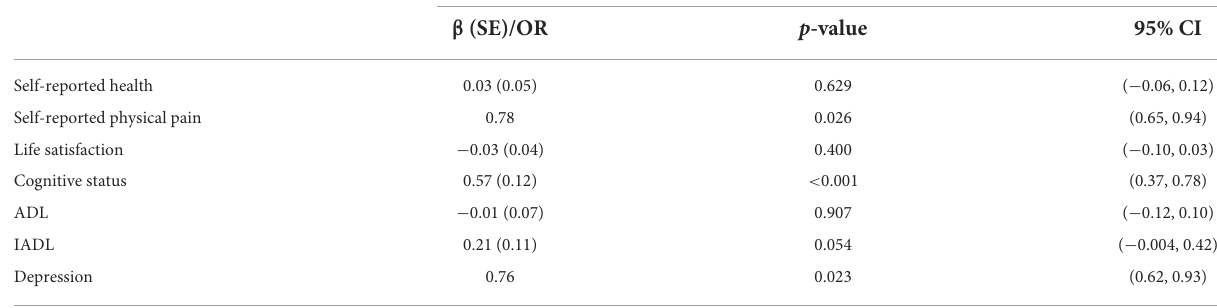
TABLE 3 Estimation of the intervention effect of retirement on the health of elderly individuals. Outcome variables